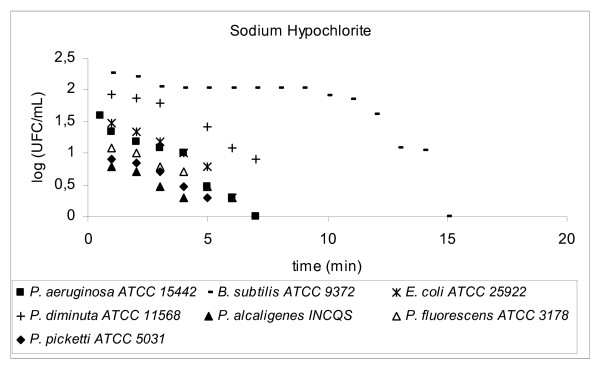
Graphic representation of the standard and in house microorganism reduction against different sanitizers.